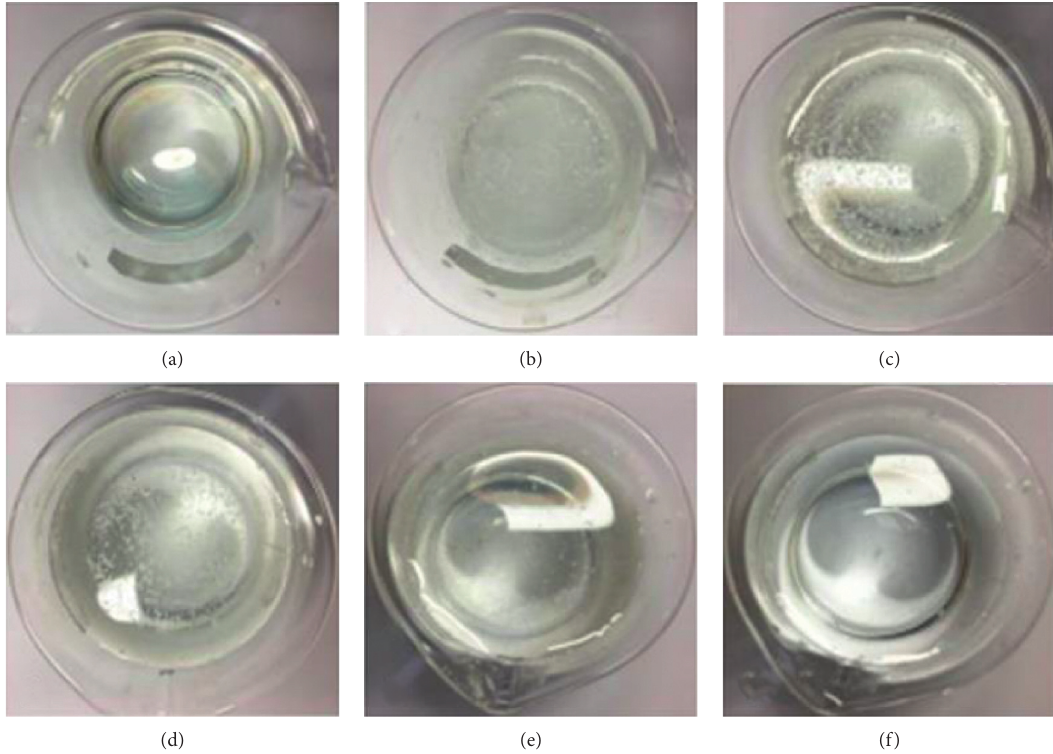
Figure 2: The solubility of water-soluble white particles. (a) Diverting agent +tap water; (b) diverting agent+10 ml of chelate acid; (c) 100ml of fresh water is added for the first time, pH < 1; (d) 300ml of fresh water is added for the second time, pH � 4; (e) 500ml of fresh water is added for the third time, pH � 5; and (f) 1000ml of fresh water is added for the fourth time, pH � 7.